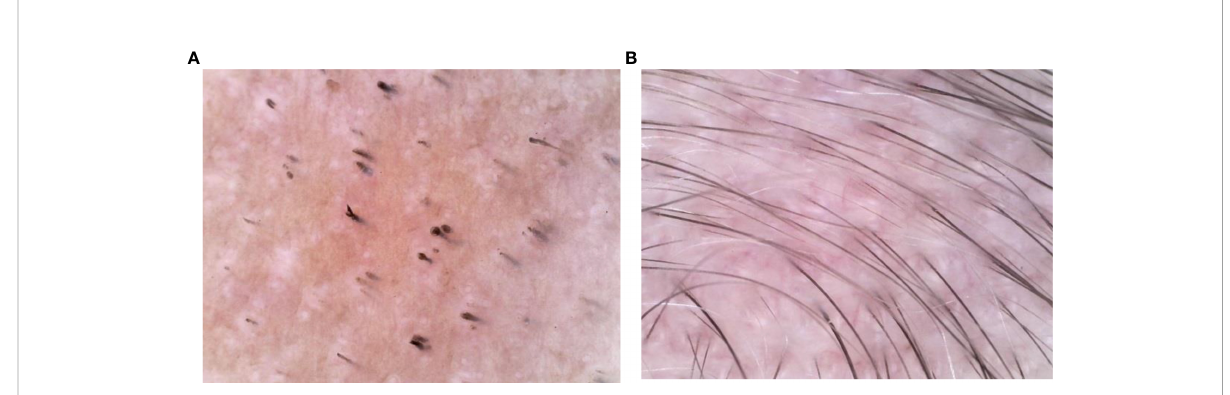
FIGURE 2 (A, B) Dermoscopy show that before treatment, there were yellow spots, black spots, broken hairs and exclamation mark hairs in the patient ’ s skin lesions. After 6 months of microneedling treatment, the dermoscopic signs of alopecia areata disappeared and 1-2 hairs were visible in each hair